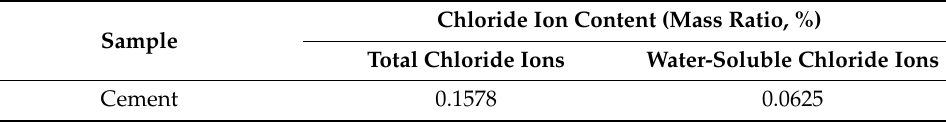
Table 2. Chloride ion components of the